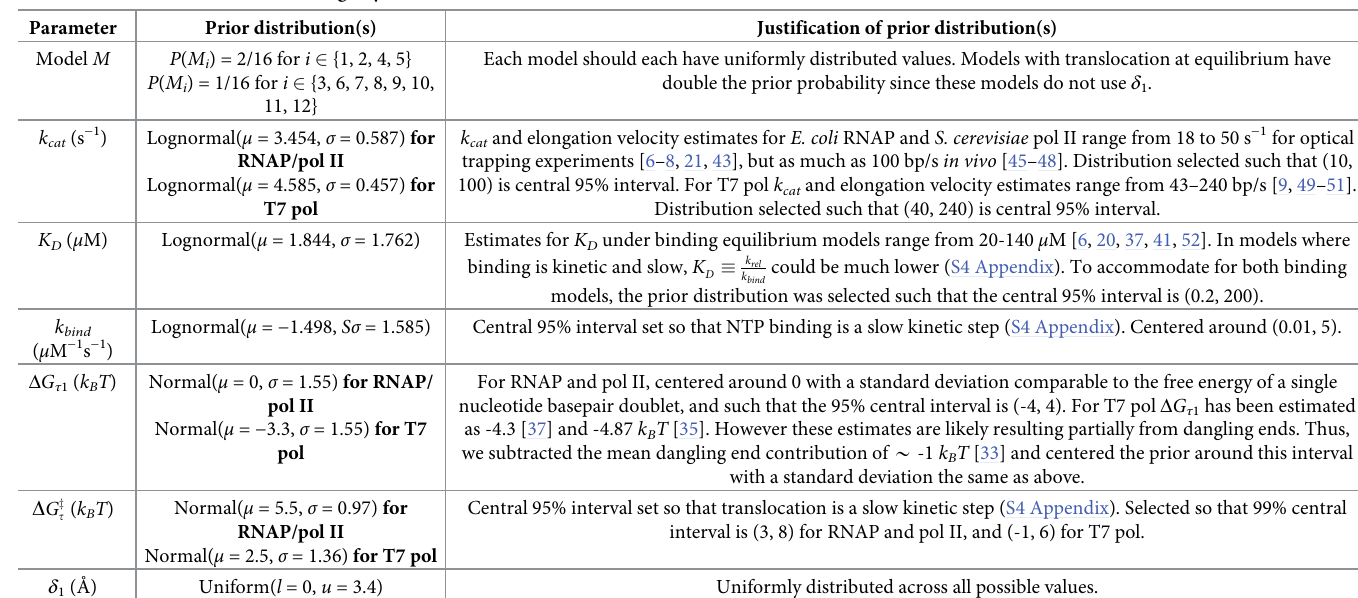
Table 1. Prior distributions used during Bayesian